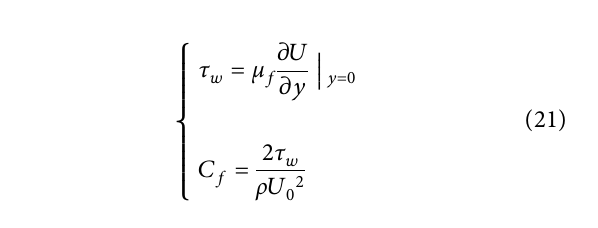
Figure 12: Normalized flow and temperature field with 6s